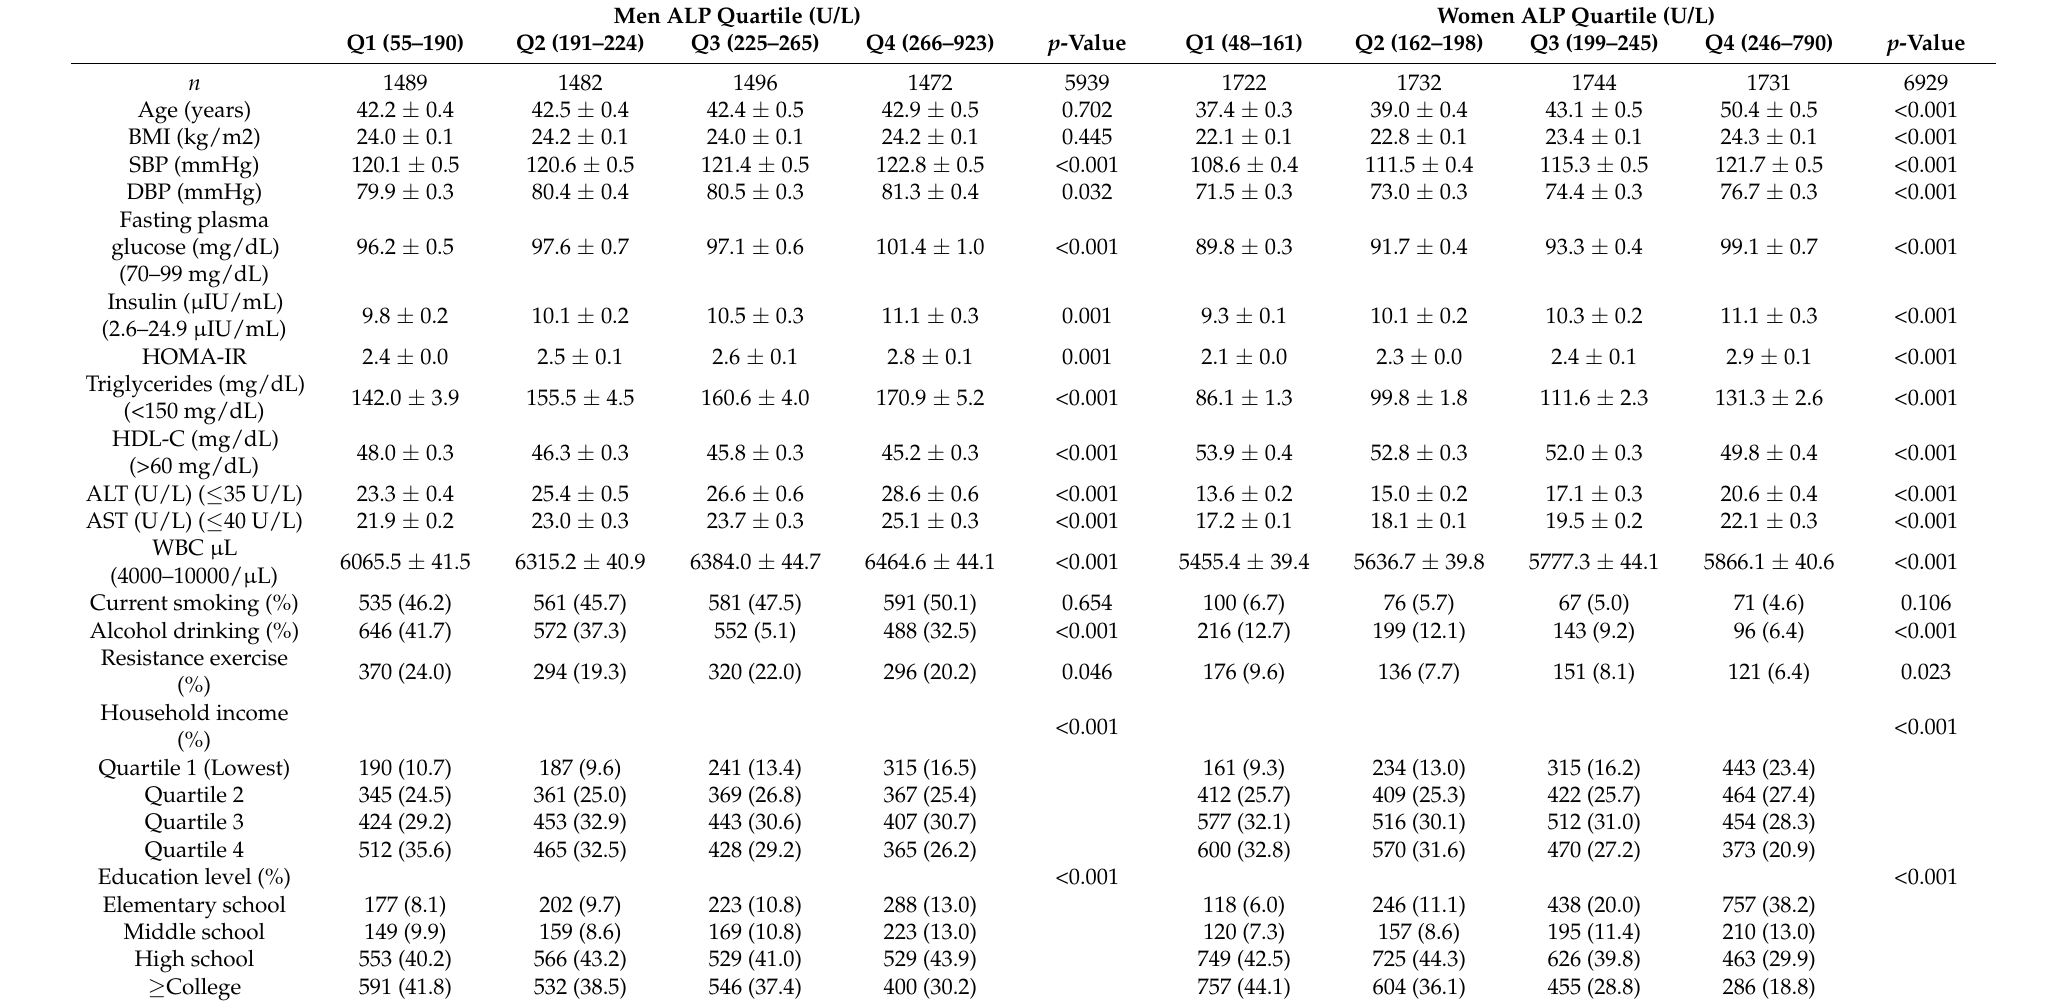
Table 1. Clinical characteristics of the study